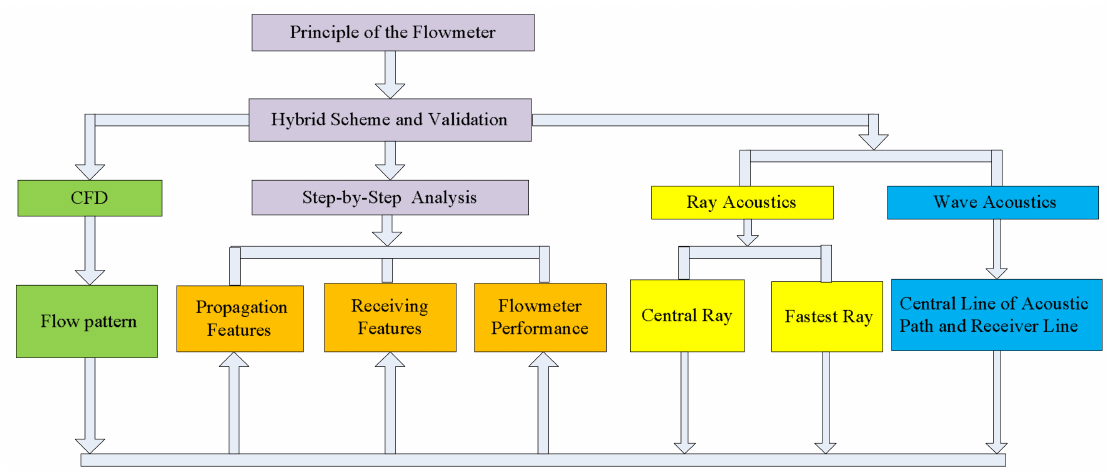
Figure 2. New hybrid scheme of flow-acoustic coupling study for a gas ultrasonic